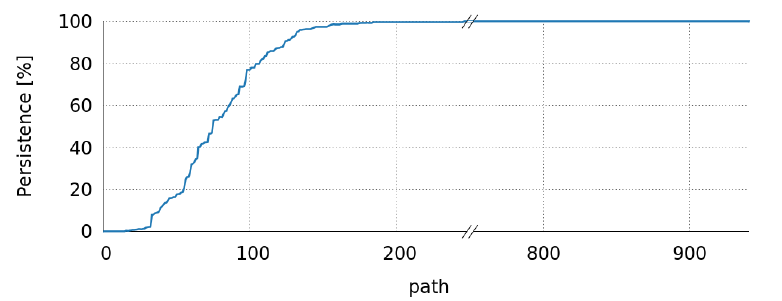
Figure 3. Persistence of